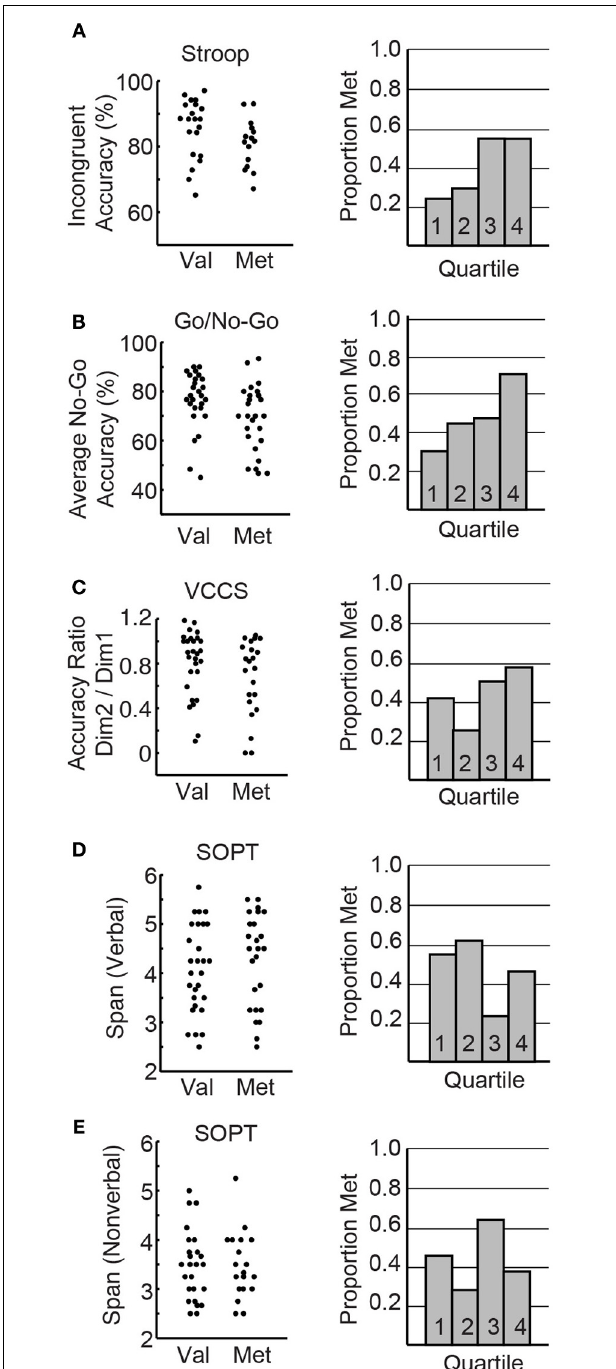
FIGURE 7 | COMT and cognitive control. The left panel depicts the primary outcome measures for each task graphed as a function of COMT variant for the individual children with 22q11.2DS. (A) Incongruent accuracy on the Stroop task. (B) Average No-Go accuracy on the response inhibition Go/No-Go task. (C) Accuracy ratio (Dimension 2/Dimension 1) on the VCCS. (D,E) Verbal and non-verbal span, respectively, on the most difficult level of the self-ordered pointing test (6 items to remember). The right panels of the figure depict the proportion of individuals within each performance quartile of the particular task that had the Met variant of the COMT